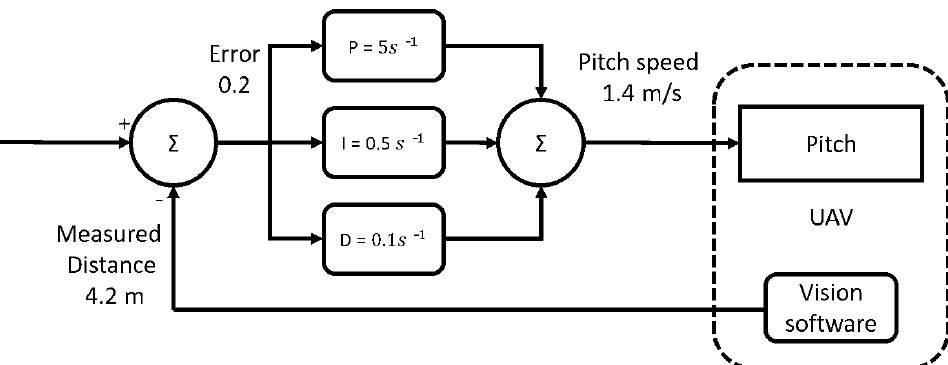
Figure 5. A proportional-Integral-Derivative control loop. The D factor damps the overshoot induced by P and